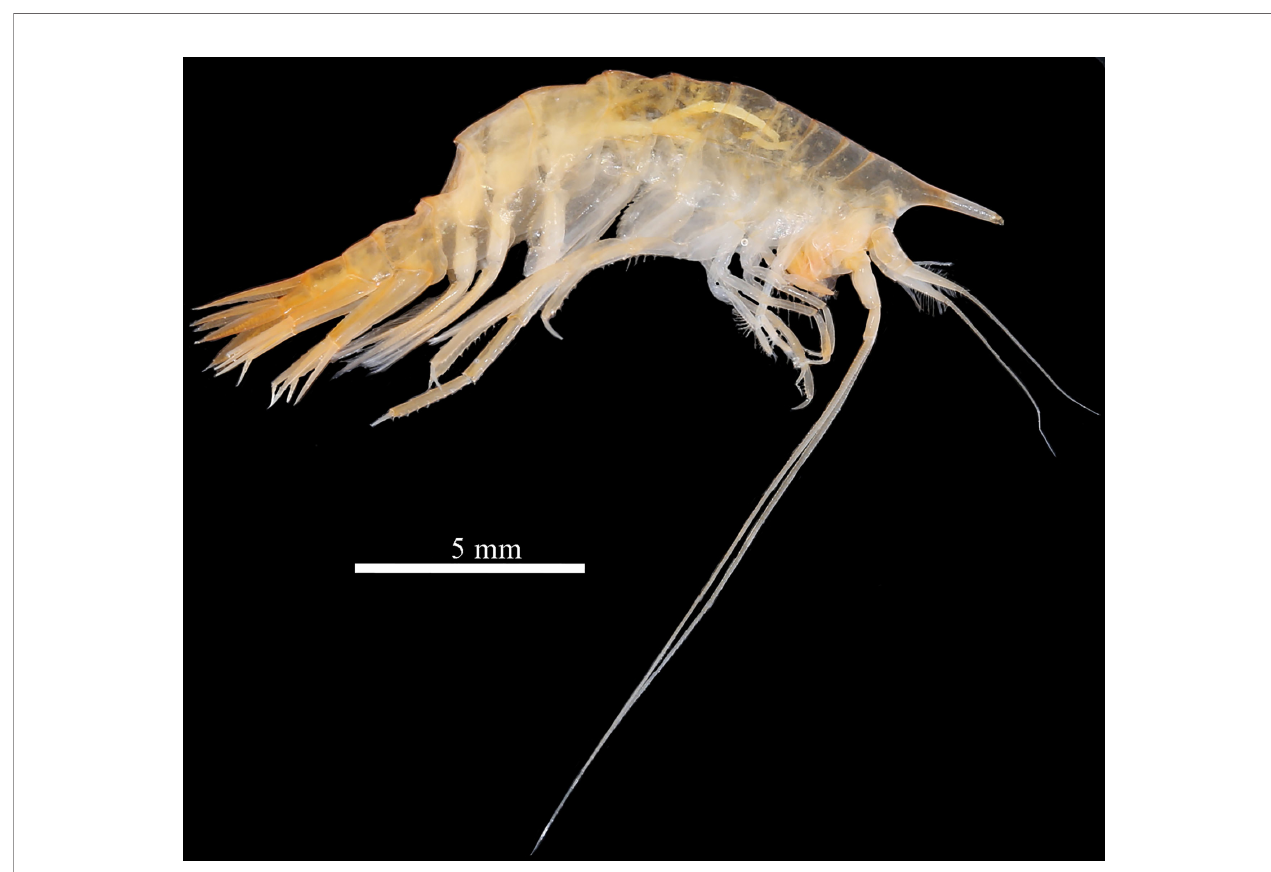
FIGURE 8 | Cyphocaris formosa sp. nov., MBM 286820, male holotype (19 mm), photographed immediately after sorting from the zooplankton samples by Ziming